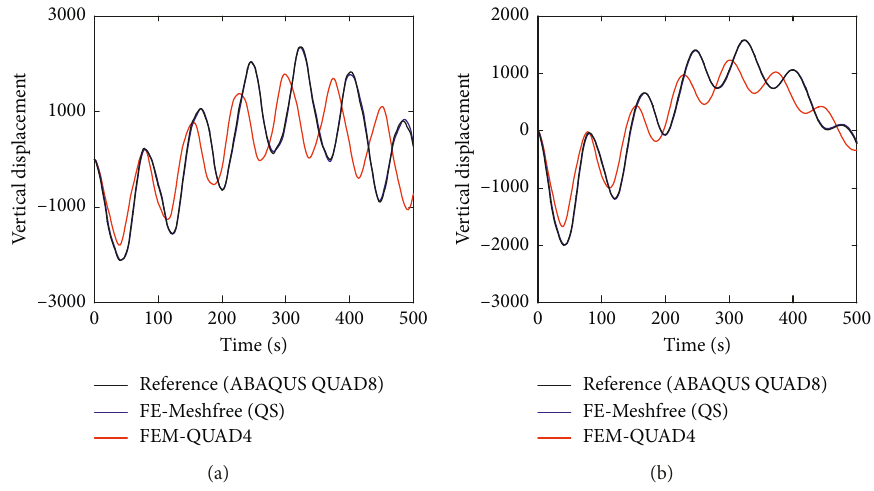
Figure 31: Transient response of spherical shell subjected to harmonic loading with ω